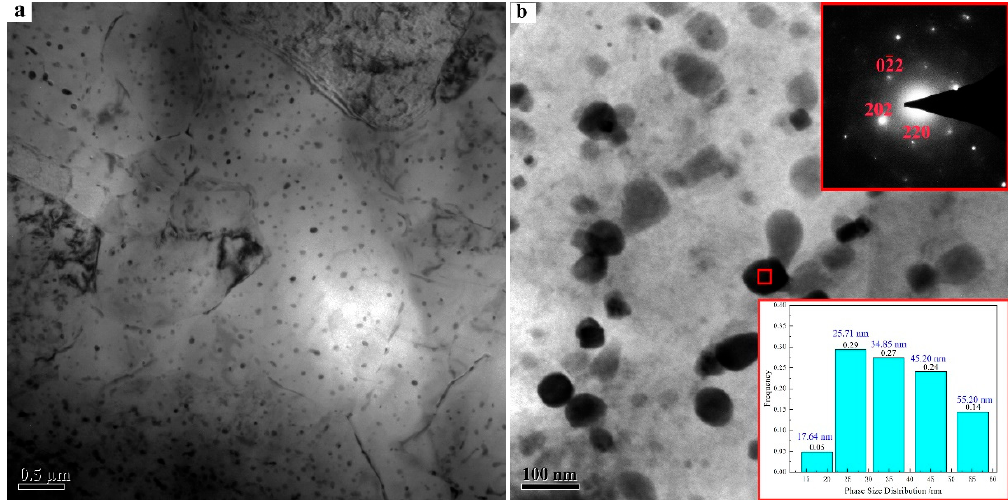
Figure 3. TEM images of the RS Mg 96.9 Gd 2.7 Zn 0.4 (at.%) ribbon. ( a ) The bright field (BF) TEM image, ( b ) the magnified BF TEM image of β 1 phase particles; the insert (up) displays the selected area electron diffraction pattern of β 1 phase in which the beam is parallel to [ − 111]; the other insert (down) shows the particle size distributions of β 1 phase with the mean size of 35.6 nm.